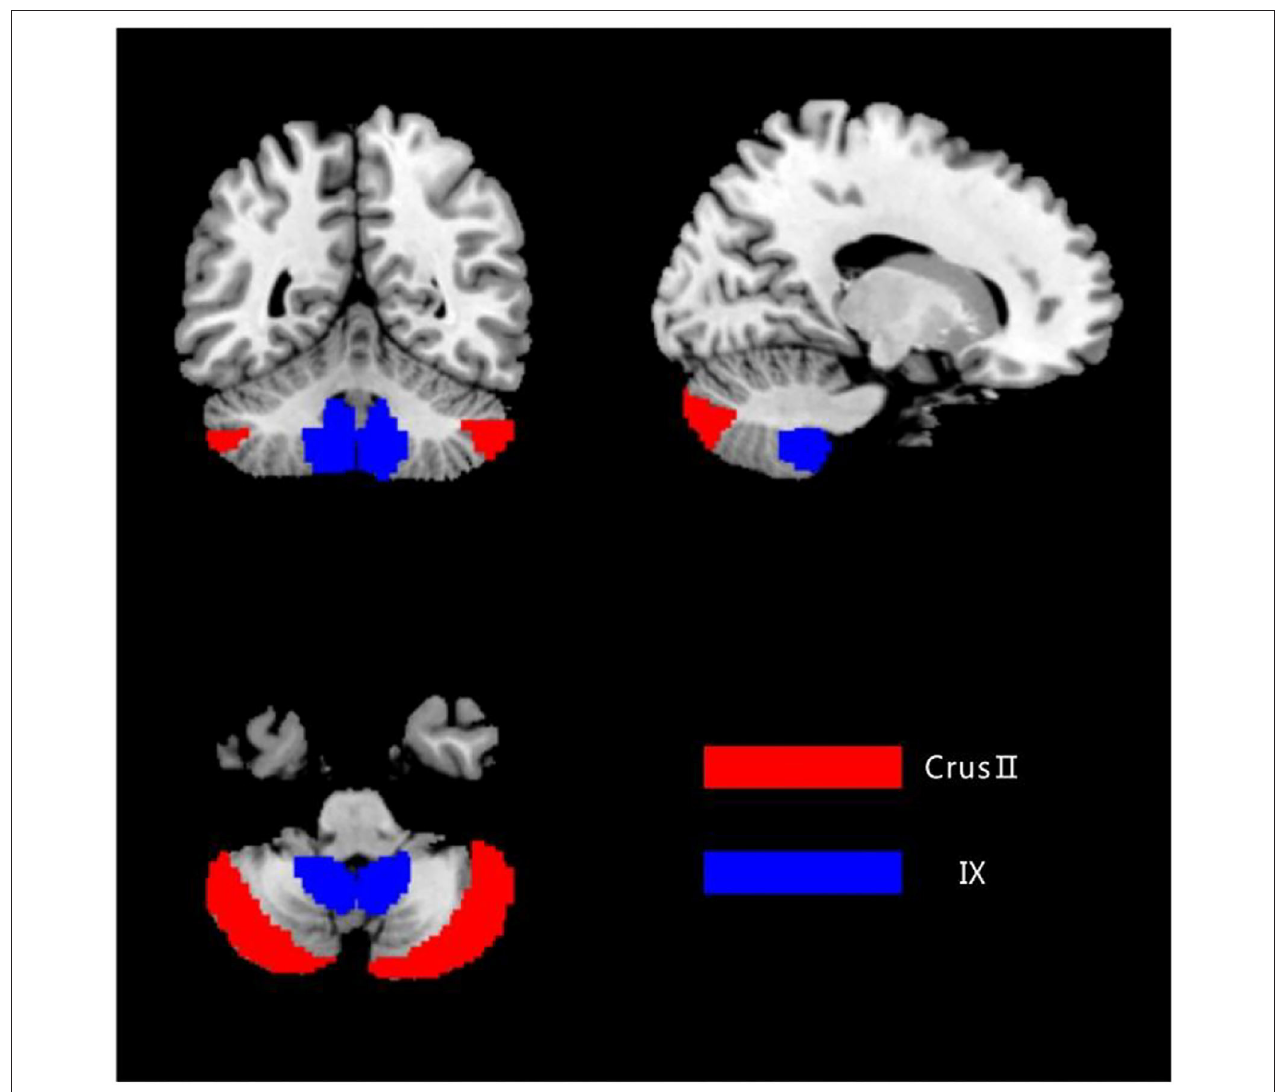
FIGURE 1 | The ROIs of the cerebellum. The image was transformed into the space of the SUIT atlas and was overlapped by the seeds. Red color represents the Crus II, and blue color represents the posterior lobule IX.